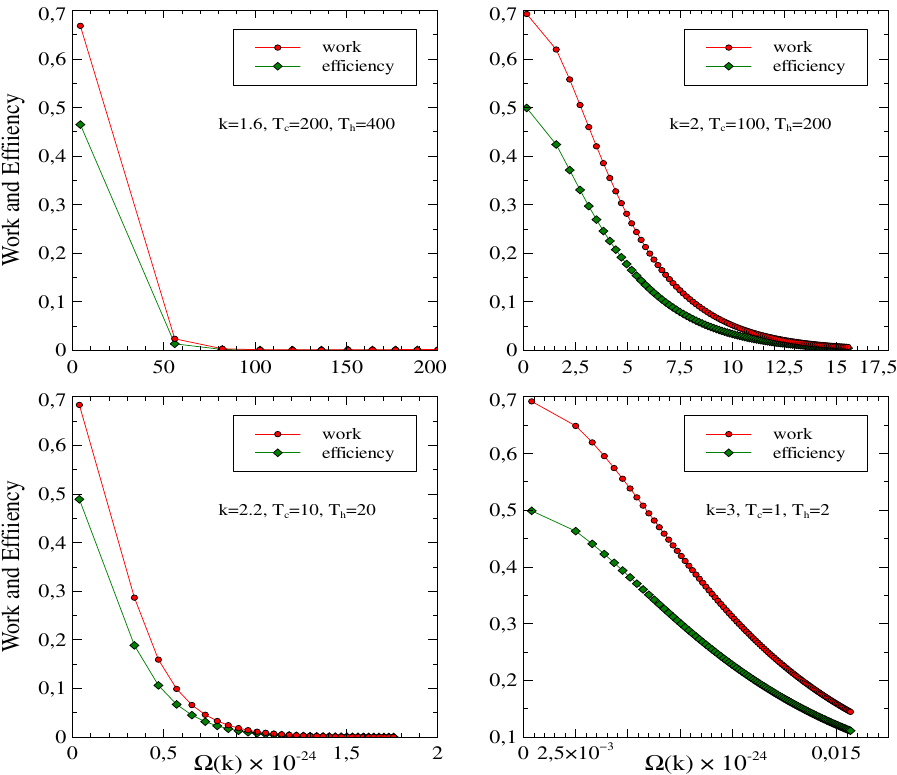
Figure 2. Work and efficiency versus �( k ) for several k and temperature values. Here, we have set the constants 11 19.11 10 1.380649 as m , k B − = × =